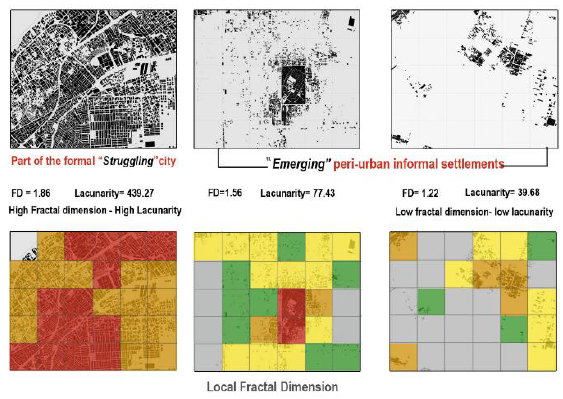
Figure 5: Examples of Fractal cells representing different growth types in Alexandria - Source: Hasan,2012